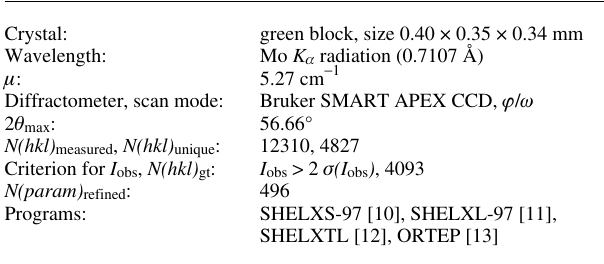
Table 1. Data collection and handling.